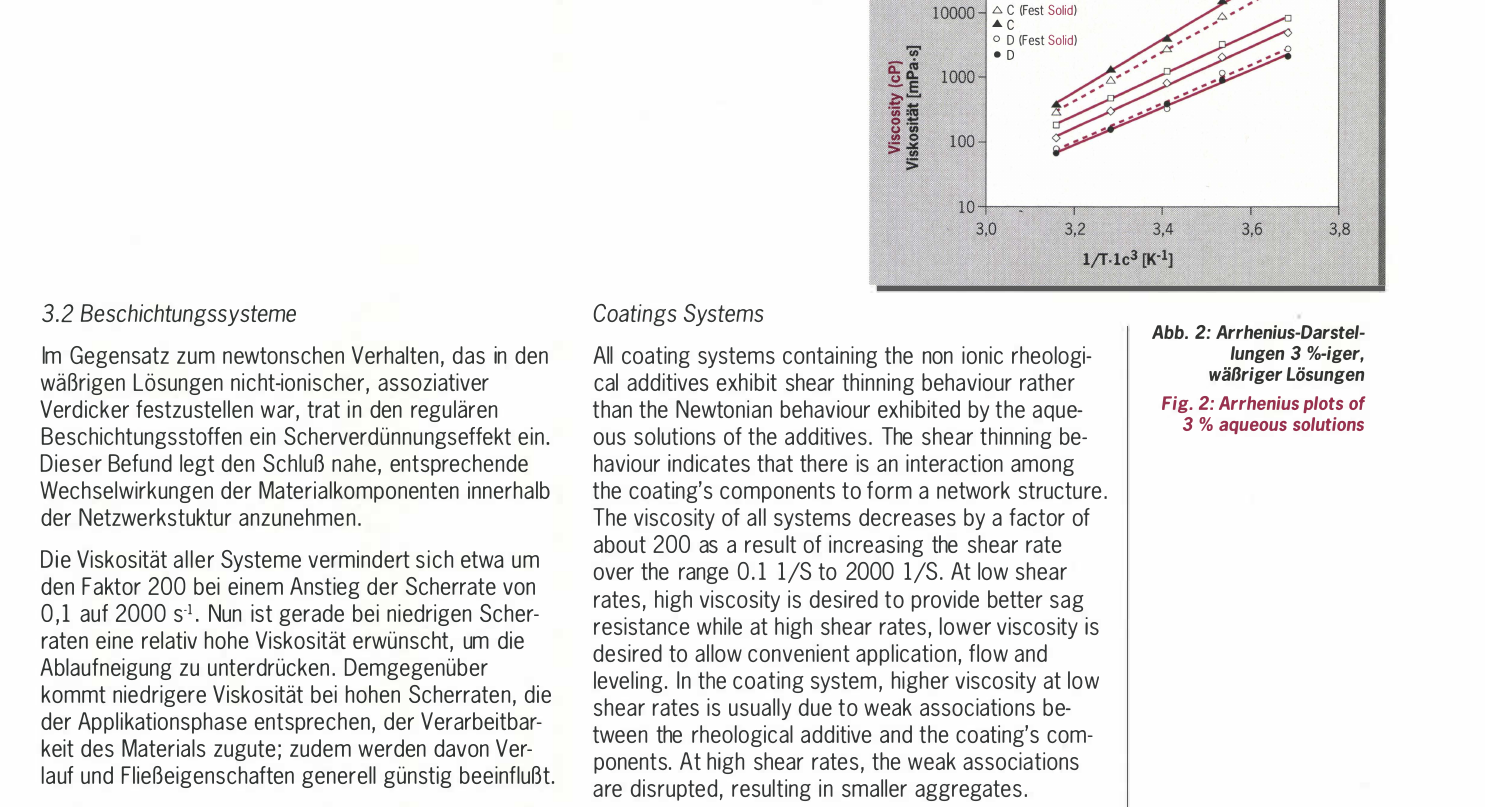
Abb. 3: Beschichtungsstoff­